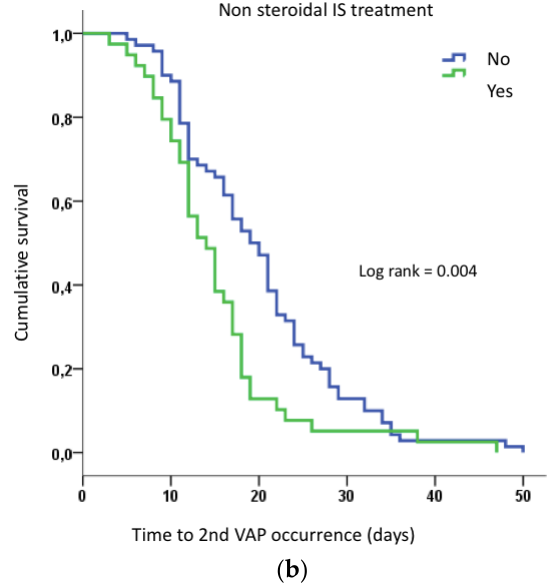
Figure 3. ( a ): Cumulated survival probability before 2nd VAP occurrence according to the use of steroidal IS treatment (subjects were censored at the time of VAP recurrence). ( b ): Cumulated survival probability before 2nd VAP occurrence according to the use of non-steroidal IS treatment (subjects were censored at the time of VAP recurrence). IS: immunosuppressive; VAP: ventilator- associated